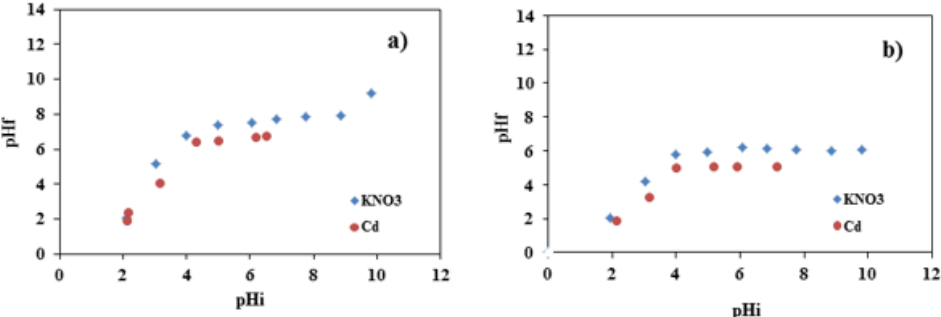
Figure 1. pHpzc in KNO 3 and Cd 2+ solution for CS ( a ) and MCS ( b ).